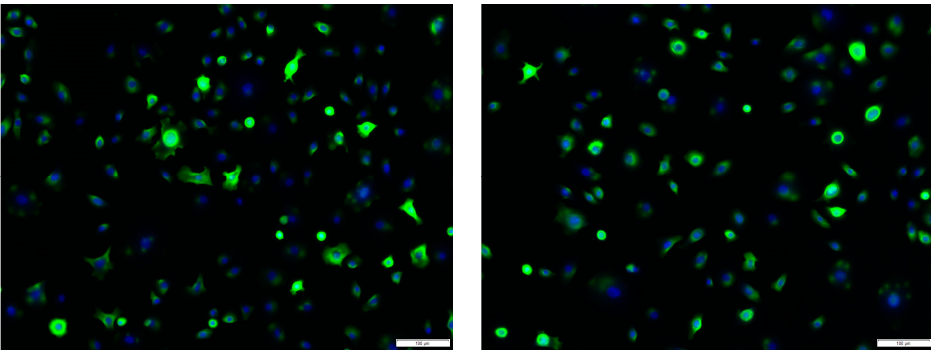
Figure 5. PAN-cytokeratin immunofluorescence staining of primary human keratinocytes (green). Counterstaining was performed with DAPI (blue). Scale bar 100 µm.